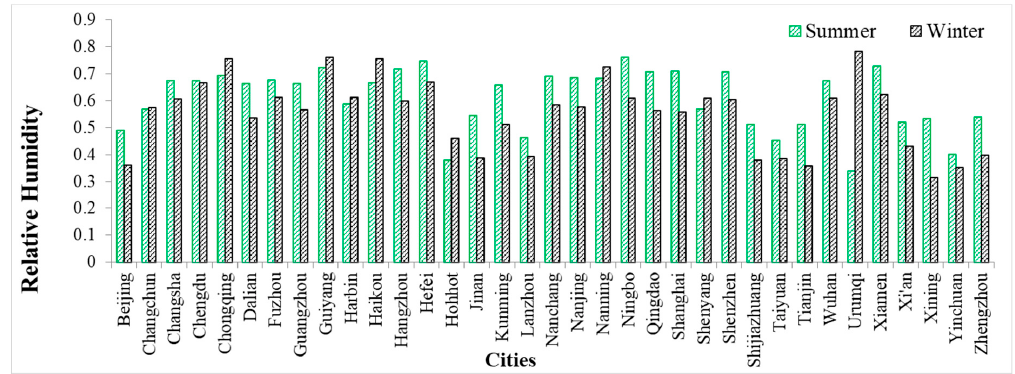
Figure 15. Comparisons of mean RH in each city in summer (green bars) and winter (black bars). In summary, the above analyses suggest that the effects on seasonal SIAP are complex, likely